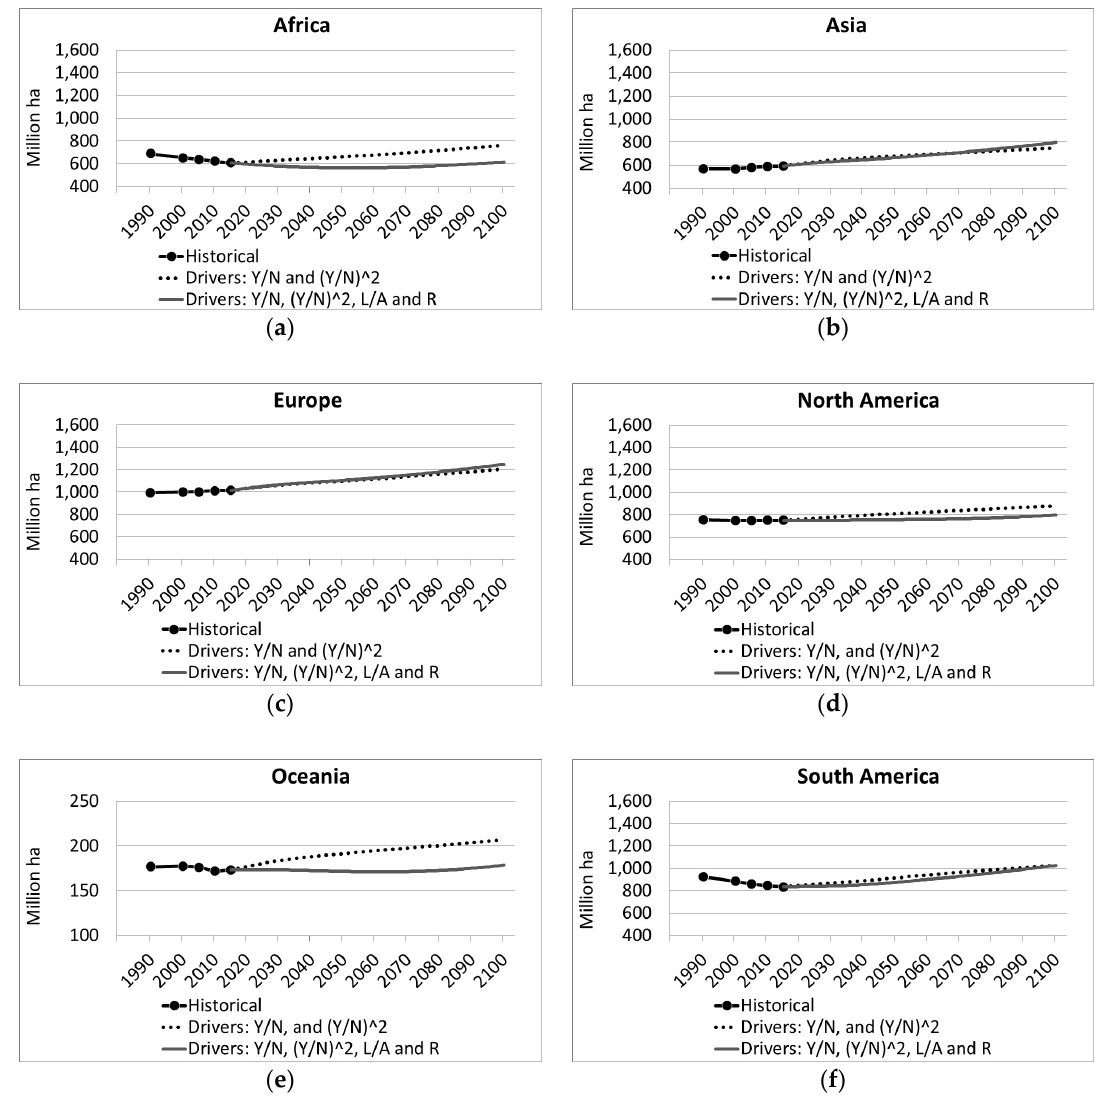
Figure 4. Projected total forest area (million ha) for major world regions under shared socioeconomic pathways two (SSP2), 2015–2100. The dotted line shows forest area projections driven by only per capita income and its squared value, and the solid line shows the projections driven by per capita income, its squared term, rural population density, and labor per unit forest area. The results represent 48 countries in Africa ( a ), 46 in Asia ( b ), 36 in Europe ( c ), 17 in North America ( d ), nine in Oceania ( e ), and 12 in South America ( f ).